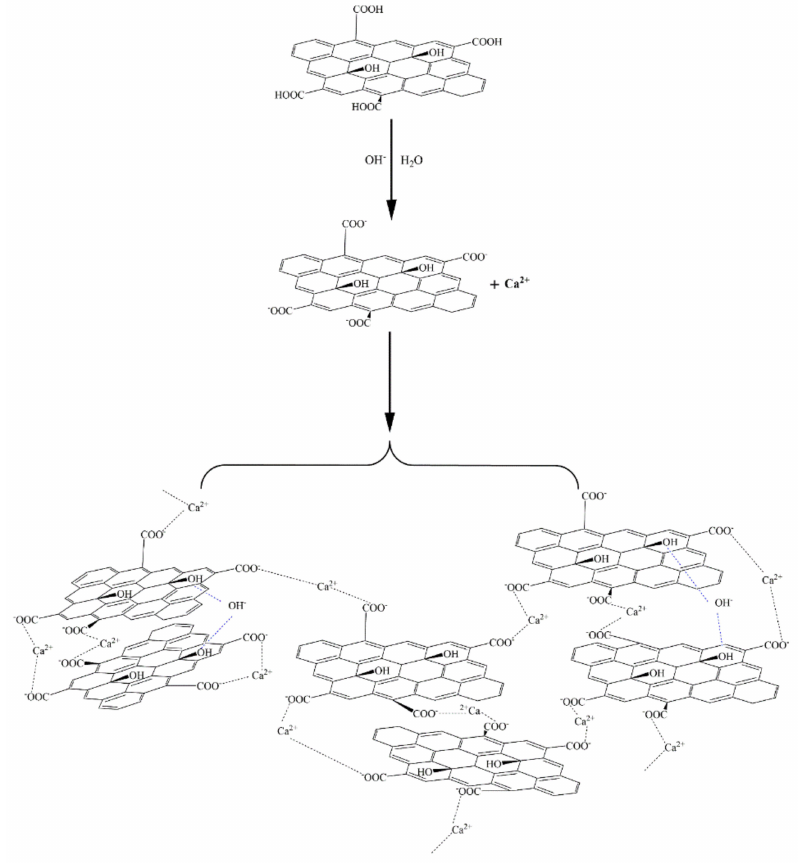
Figure 21. Formation of GO aggregates in simulated pore (Ca(OH) 2 )